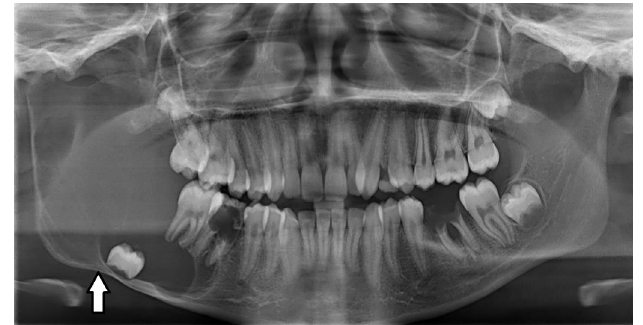
Fig. 4. Pantomograph showing multilocular, soap-bubble appearance of an ameloblastoma in the right mandible.